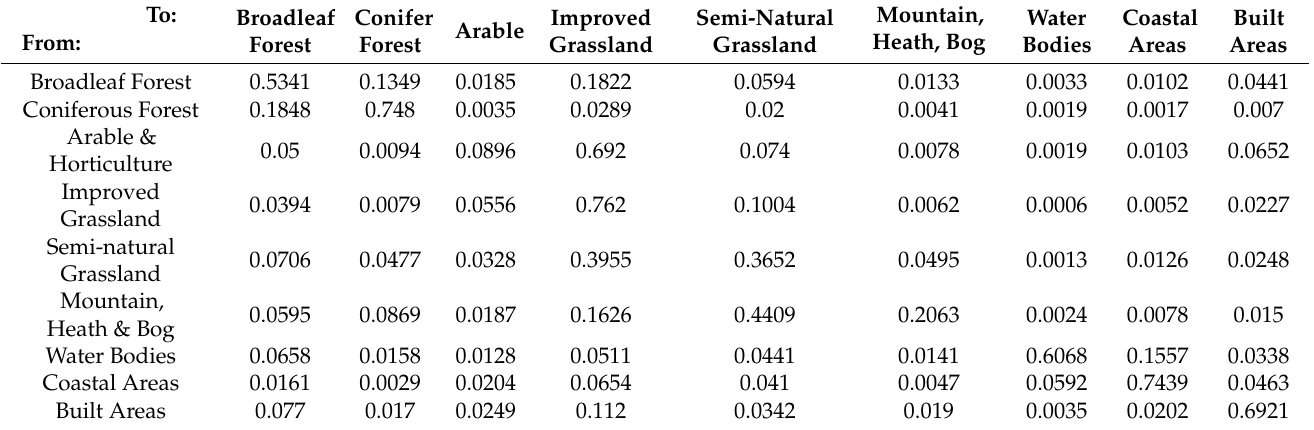
Table 3. Markov Chain transition probability matrix showing the probability of LULC transitions based on changes observed between 2007 and 2015 (in